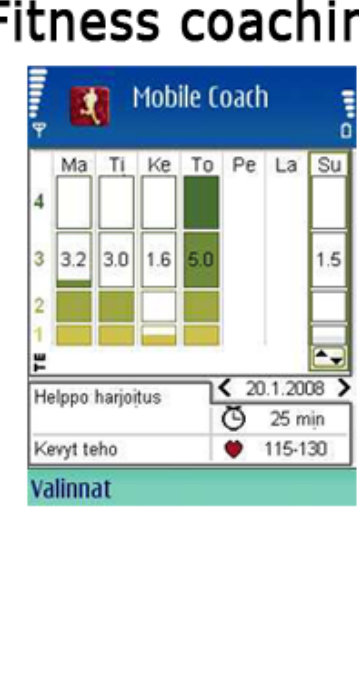
Figure 3. Screenshots of the 3 mobile